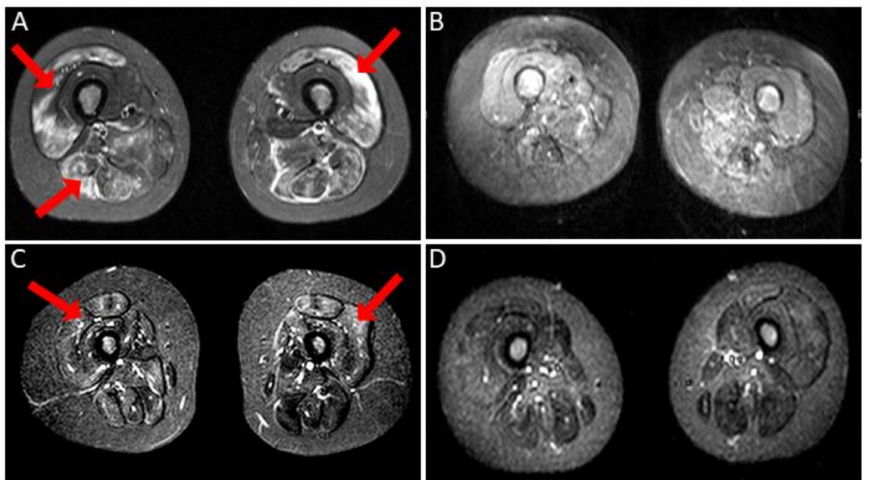
Figure 1. Magnetic resonance imaging (MRI) of both patients using the short tau inversion recovery (STIR) sequence. Patient 1: patchy, symmetrical edema of the thigh muscles at onset ( A , arrows) and normalization of the STIR signal as well as marked fatty atrophy of the previously affected thigh muscles after one year of therapy ( B ). MRI–STIR sequence of Patient 2: patchy signal elevation predominantly in the quadriceps muscles, left more pronounced than the right, 4 months after starting therapy ( C , arrows). Reduced signal elevations and atrophy of the quadriceps muscles at 10-year follow up ( D